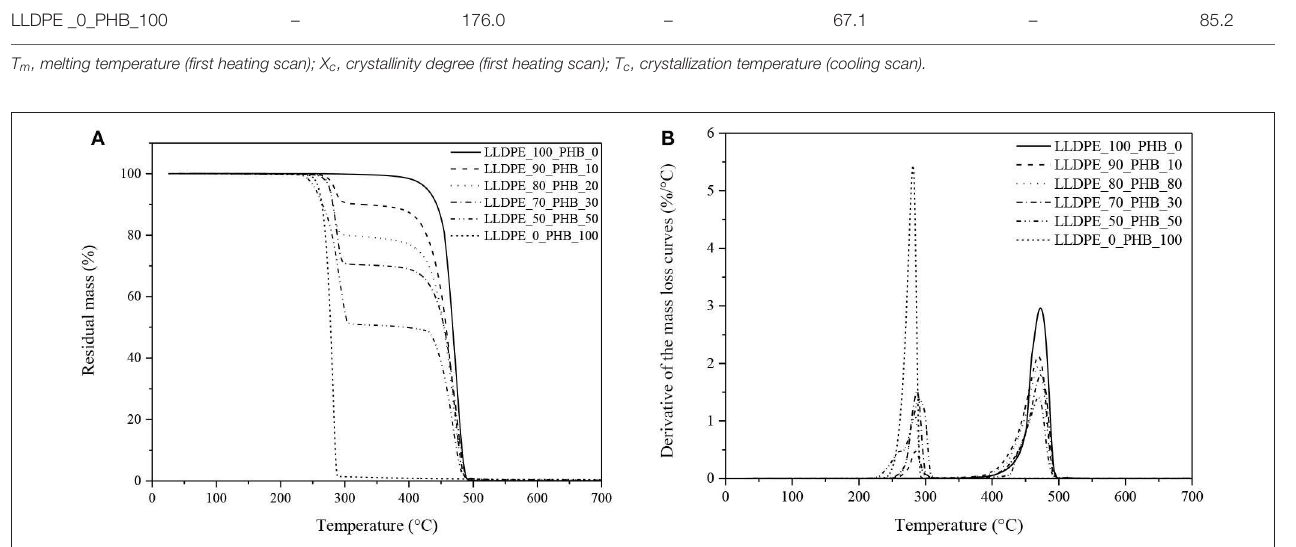
FIGURE 5 | Thermogravimetric analysis on neat LLDPE, neat P(3HB) and relative LLDPE/P(3HB) blends. (A) Residual mass and (B) derivative of the mass loss